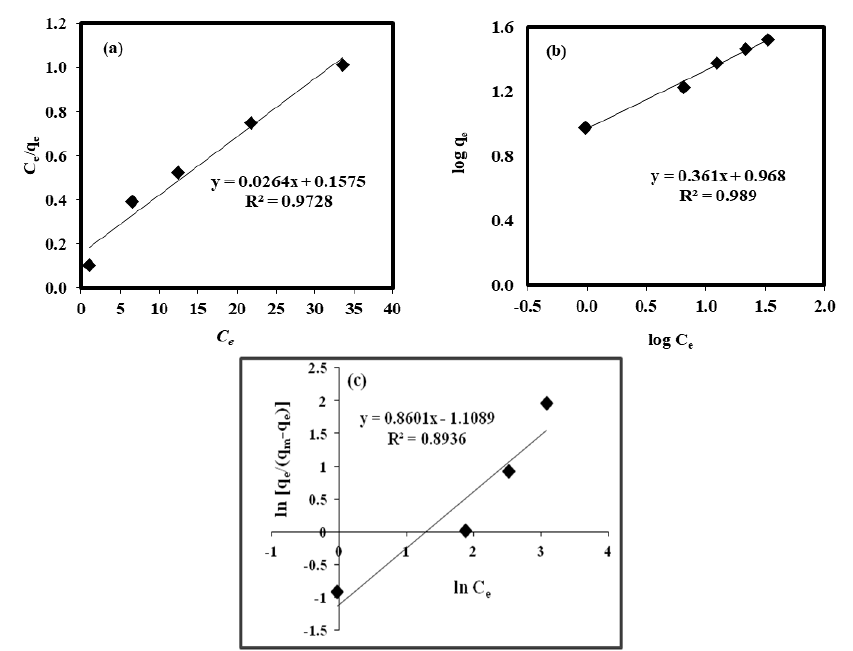
Figure 5. Linearized ( a ) Langmuir isotherm, ( b ) Freundlich isotherm, and ( c ) Sips models (adsorbent dose: 2g/L, Cu(II) concentration: 20, 40, 60, 80, and 100 mg/L, contact time: 120 min, temperature: 22 °C, volume of solution: 100 mL). Table 3. Values of Langmuir and Freundlich constants.